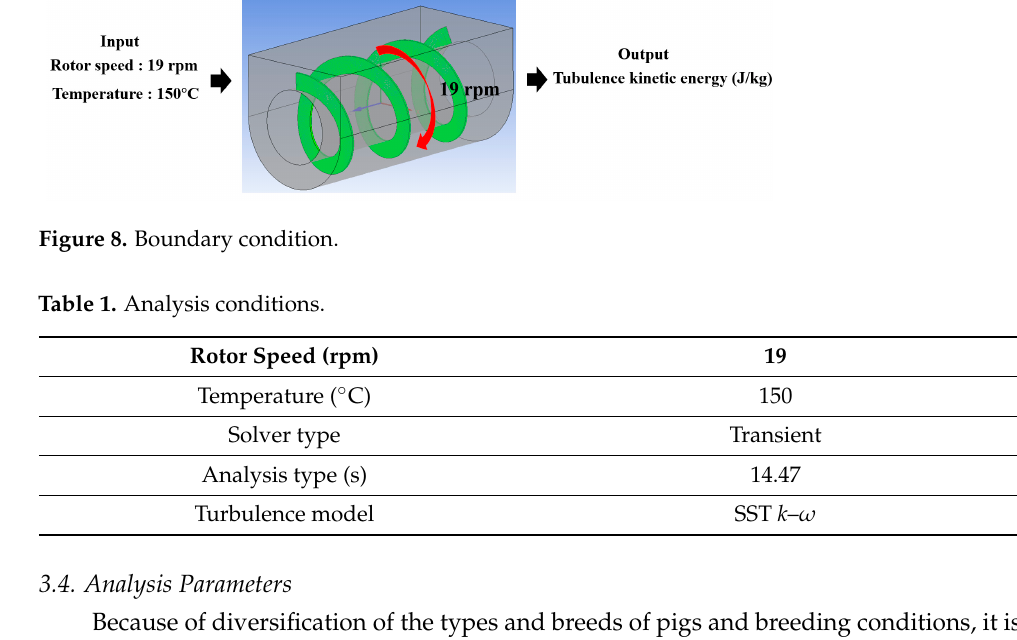
Table 2. Results of turbulence kinetic energy (J/kg).